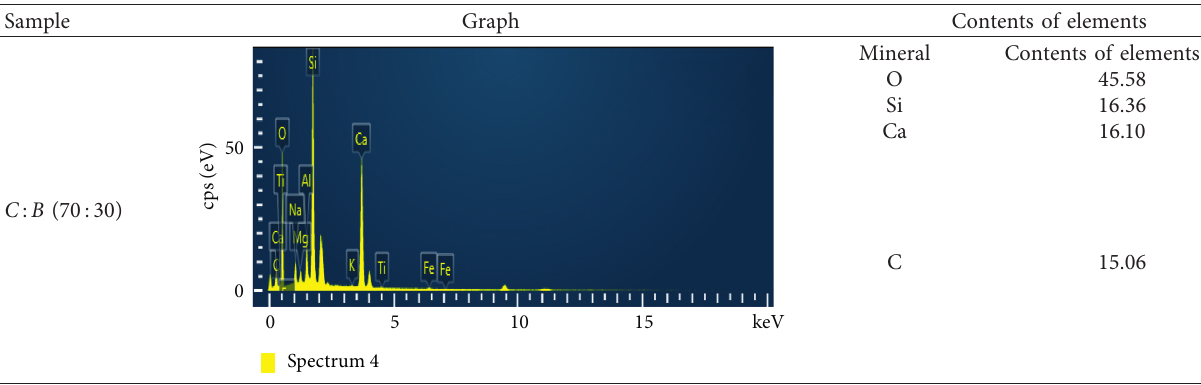
Table 6: Findings from EDX analysis for C : B of 40: